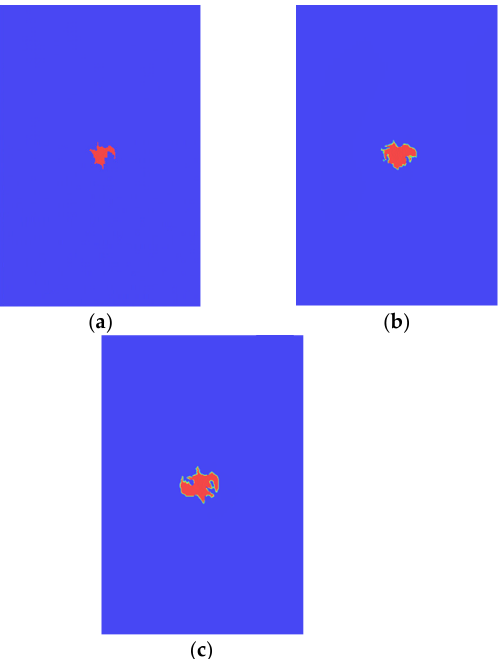
Figure 17. The intra ‐ laminar failure under different impact energy conditions. ( a ) Impact energy 30 J. ( b ) Impact energy 40 J. ( c ) Impact energy 50 J.